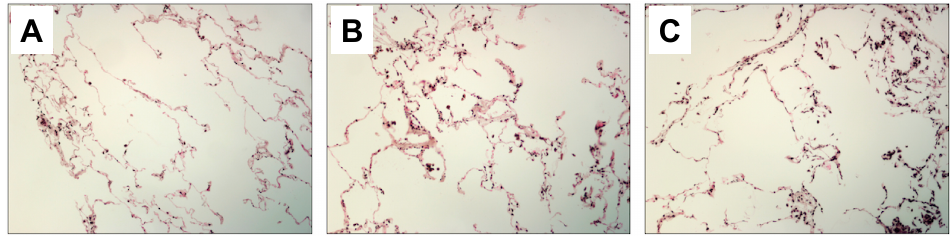
Figure 1. Human pulmonary biopsies from normal nonsmoker lung ( A ) ( n = 7); smoker without diagnosed emphysema ( B ) ( n = 15); and smoker with diagnosed emphysema ( C ) ( n = 14) were immunohistochemically stained for high-mobility group box 1 (HMGB1). Qualitatively, HMGB1 was markedly increased in the lungs of smokers ( B , C ) compared to nonsmokers. Images are representative and imaged at original magnification of 63× and 4–5 random fields were evaluated by blinded individuals as to the type of sample.